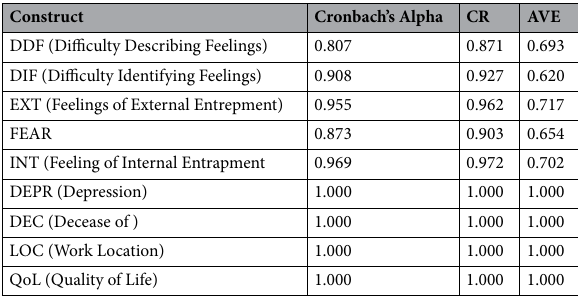
Table 2. Cronbach’s Alpha. CR. and AVE Values.